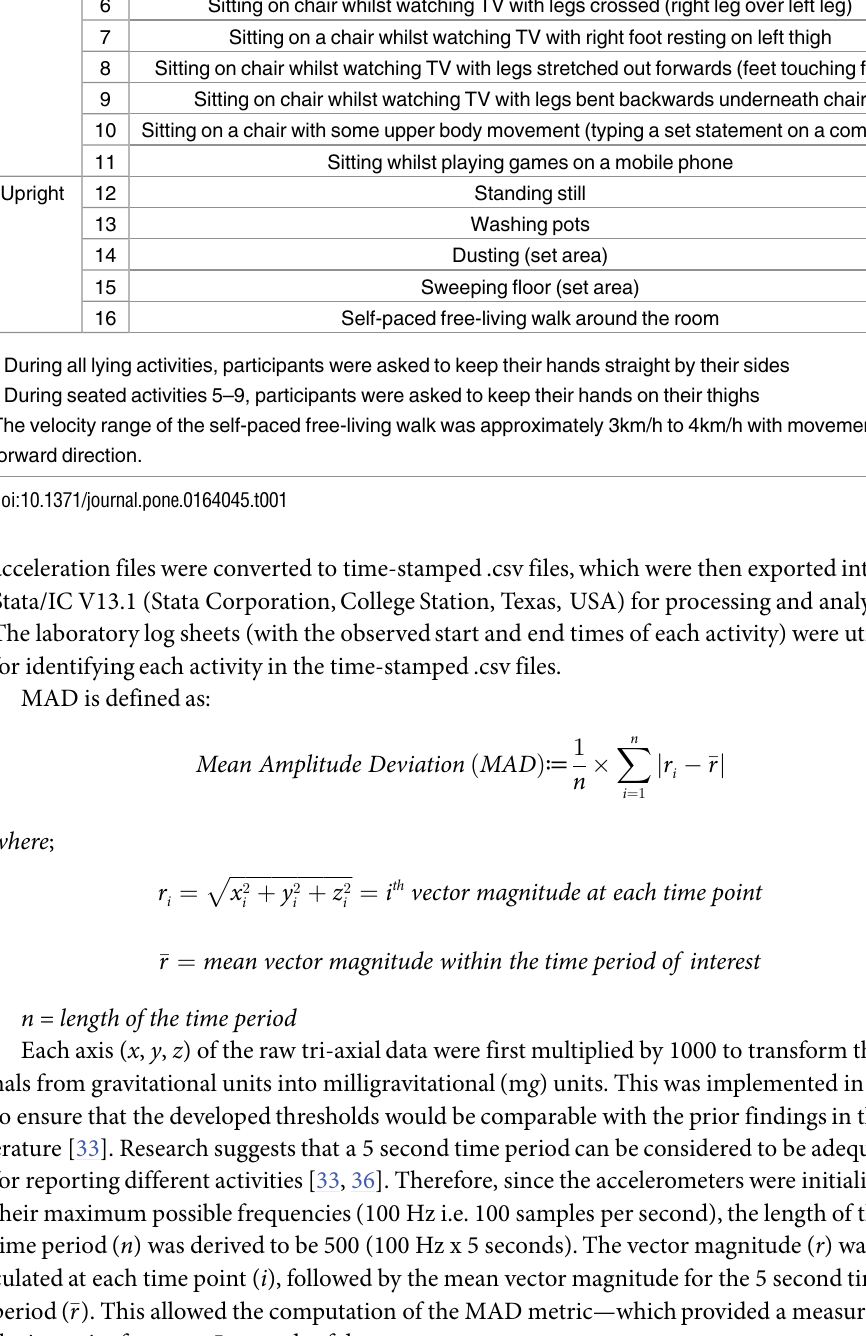
Table 1. Summary of sedentary behaviours and light-intensity physical activities. Posture